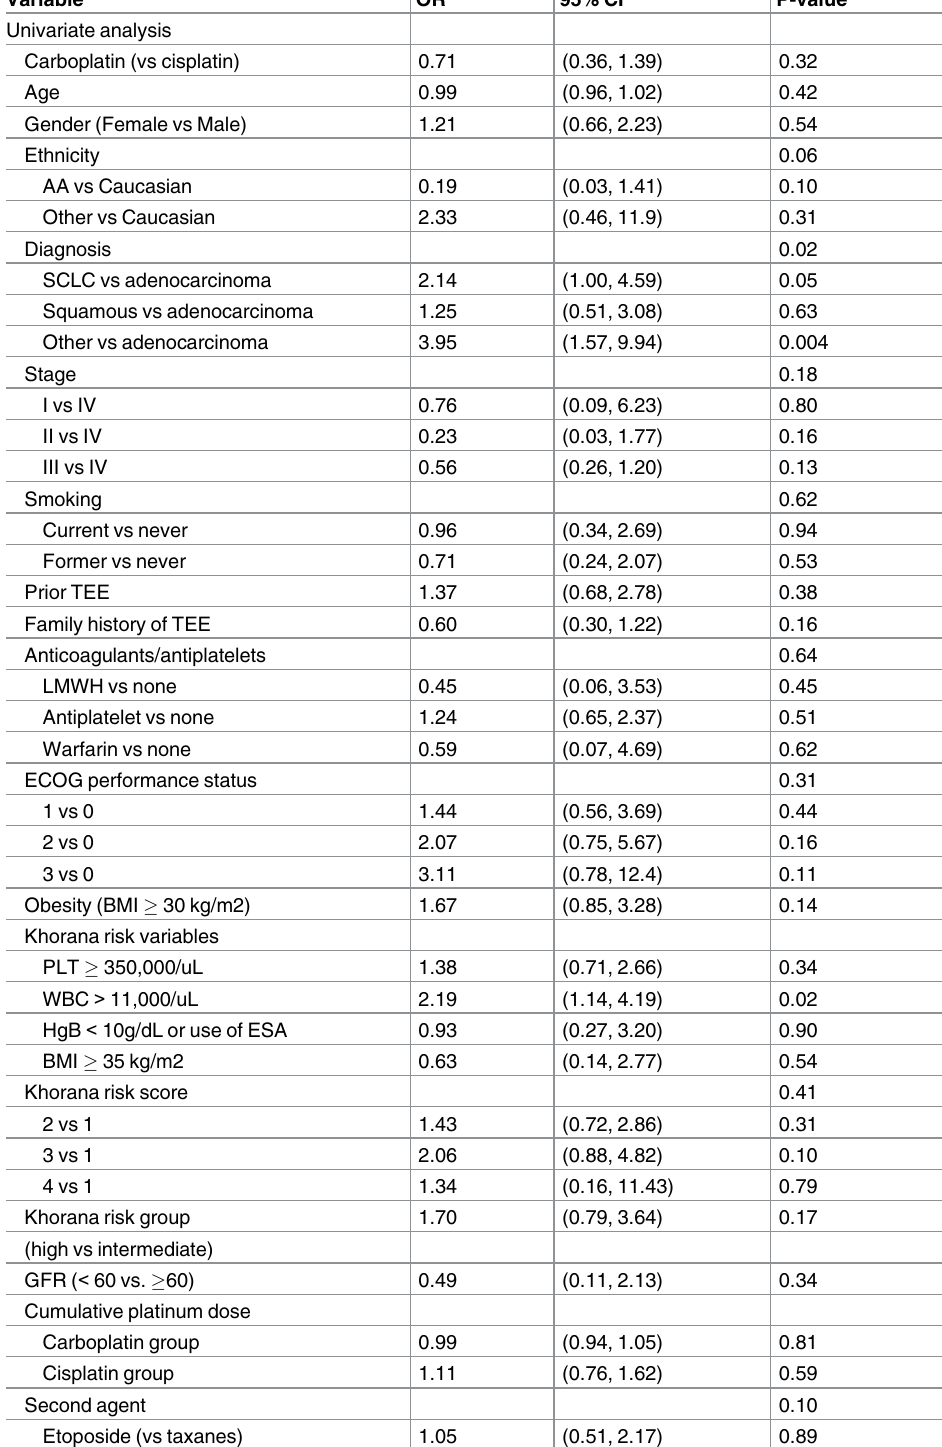
Table 3. Logistic regression analysis for thromboembolic events diagnosed during treatment or within 4 weeks post last treatment (N =